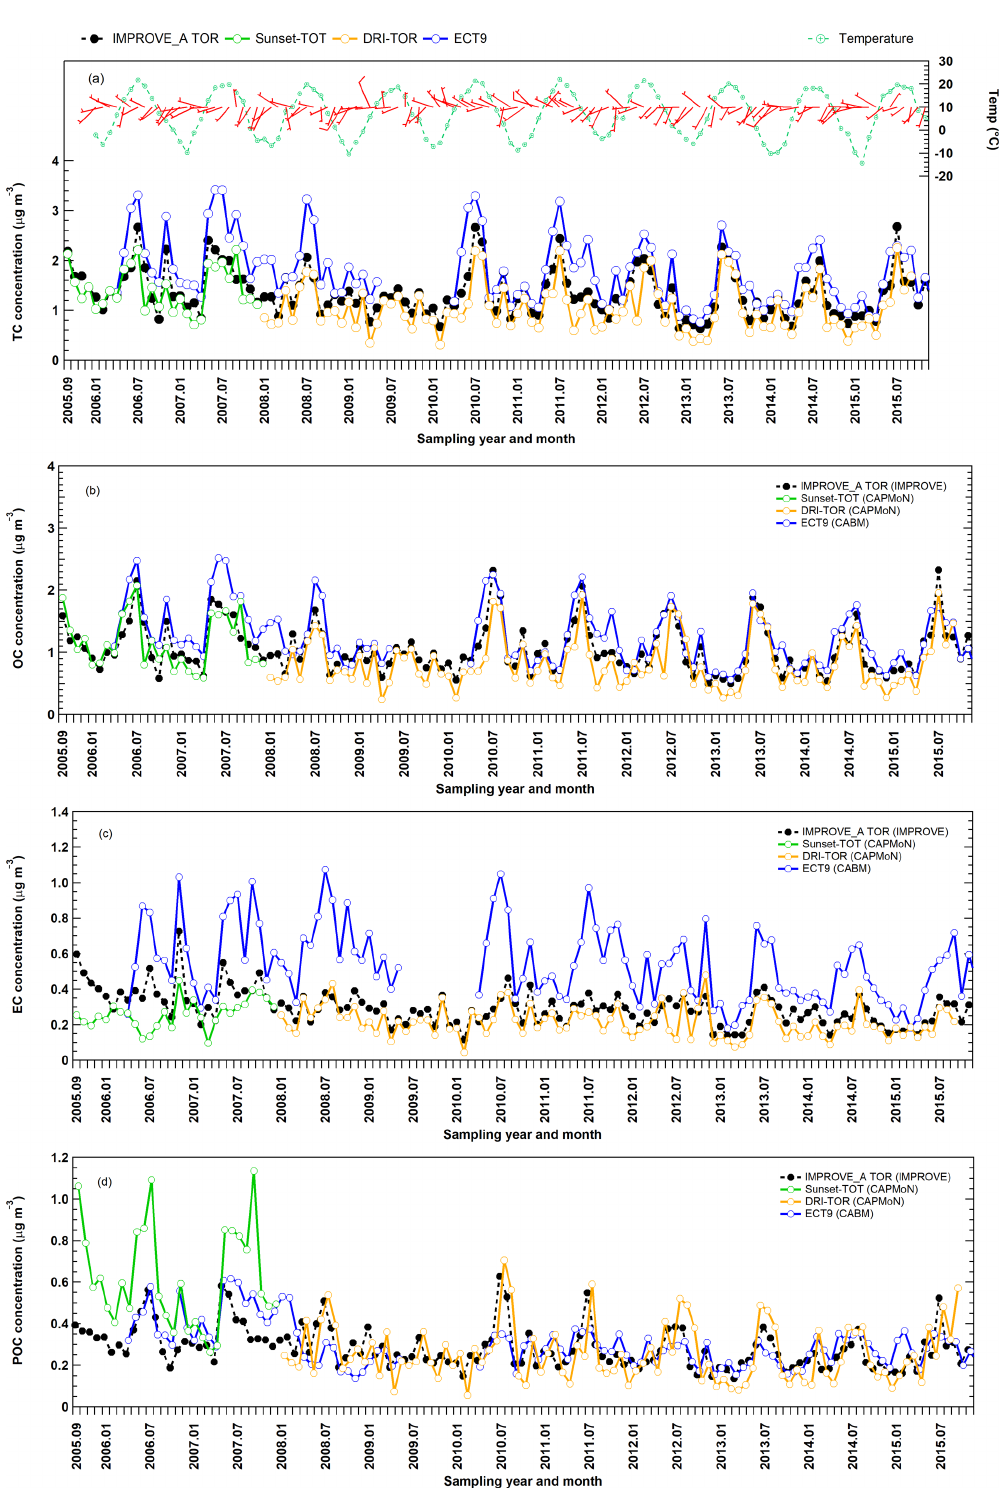
Figure 6. Monthly averaged (a) TC, (b) OC, (c) EC, and (d) POC concentration time series obtained from three different networks at Egbert. CAPMoN measurements before 2008 were obtained using the Sunset-TOT method (in green) while measurements starting in 2008 were obtained using the DRI-TOR method (in